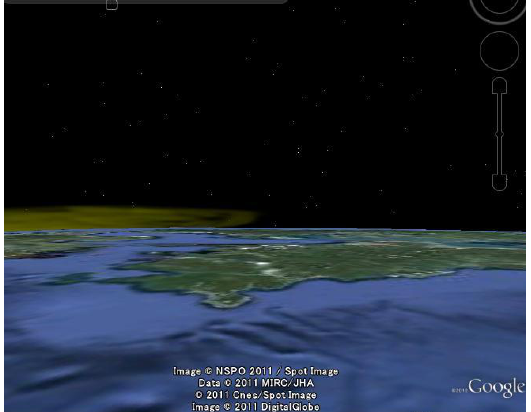
Fig. 7 Asian dust cloud at 03:00 on March 20, 2010 when we looked at the Google Earth in the transverse direction.